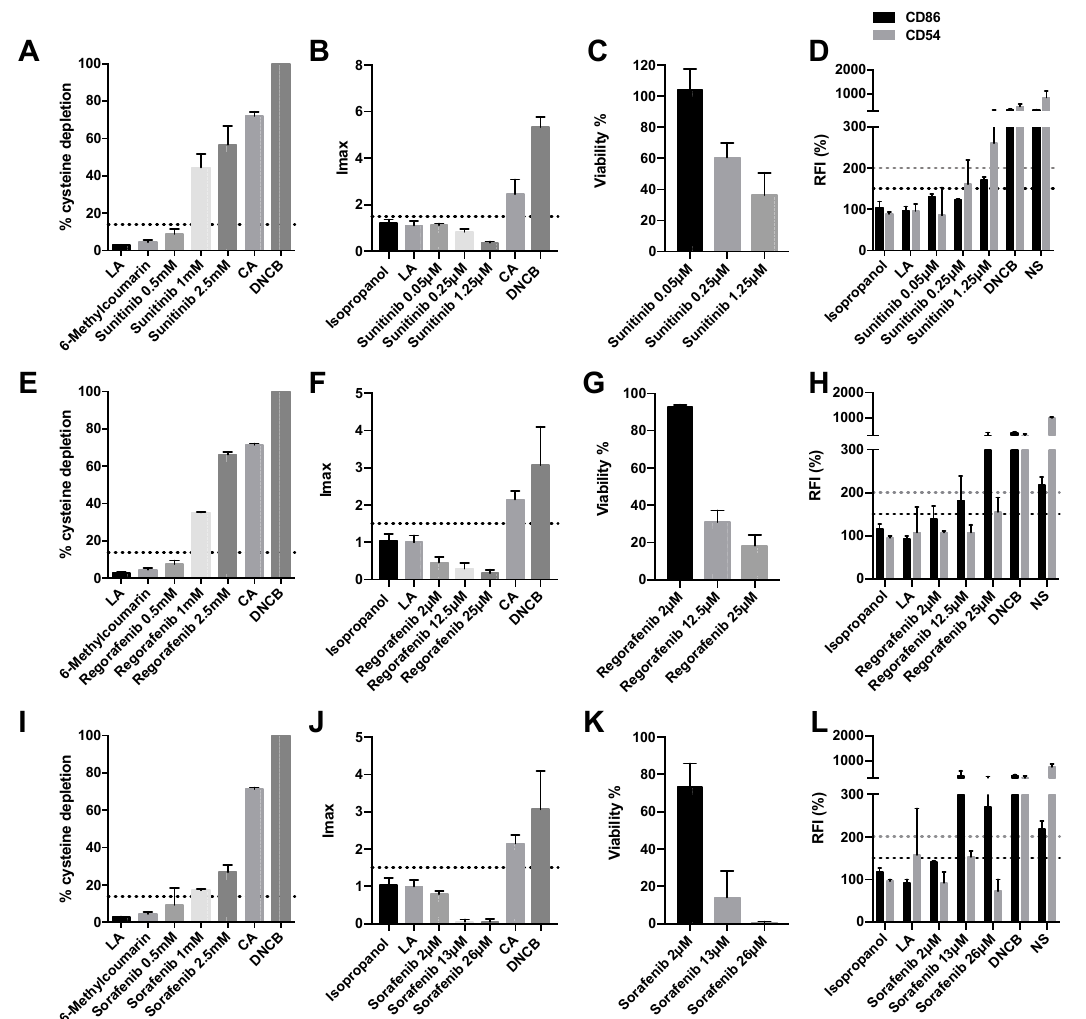
Figure 4 . Analysis of delayed-type hypersensitivity of sunitinib, regorafenib, and sorafenib by direct peptide reactivity assay (DPRA), KeratinoSens TM assay, and human cell line activation test (hCLAT). ( A ) DPRA analysis 24 h after incubation with sunitinib. Results are expressed as a percentage of cysteine depletion. ( B ) KeratinoSens TM analysis after 48 h of incubation with sunitinib. Results are expressed as luciferase activity (Imáx). ( C ) % of viability after 48 h of incubation with sunitinib. ( D ) hCLAT analysis 48 h of incubation with sunitinib. Results are expressed as relative fluorescence intensities of CD86 and CD54 ( E ). DPRA analysis 24 h after incubation with regorafenib. Results are expressed as a percentage of cysteine depletion. ( F ) KeratinoSens TM analysis after 48 h of incubation regorafenib. Results are expressed as luciferase activity (Imáx) ( G ) % of viability after 48 h of incu- bation with regorafenib. ( H ) hCLAT analysis 48 h of incubation with regorafenib. Results are ex- pressed as relative fluorescence intensities of CD86 and CD54. ( I ) DPRA analysis 24 h after incuba- tion with sorafenib. Results are expressed as percentage of cysteine depletion. ( J ) KeratinoSens TM analysis after 48 h of incubation with sorafenib. Results are expressed as luciferase activity (Imáx). ( K ) % of viability after 48 h of incubation with sorafenib. ( L ) hCLAT analysis 48 h of incubation with sorafenib. Results are expressed as relative fluorescence intensities of CD86 and CD54. Lactic acid (LA), 6-Methylcoumarin, and isopropanol were used as negative controls. 1-chloro-2,4-dinitroben- zene (DNCB), cinnamic aldehyde (CA), and nickel sulfate (NS) were used as positive controls. Shown are mean ± SEM ( n = 3). The dashed line depicts the minimum positive stimulation index.